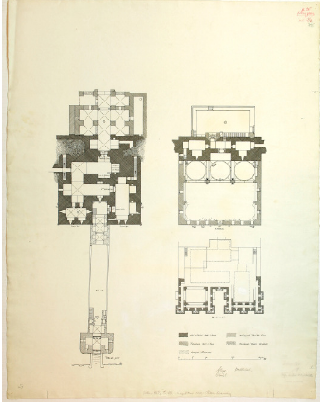
Figure 13. Architectural drawings of the Ayyubid entrance block to the Aleppo citadel by E. Herzfeld (1879 ˗ 1948)